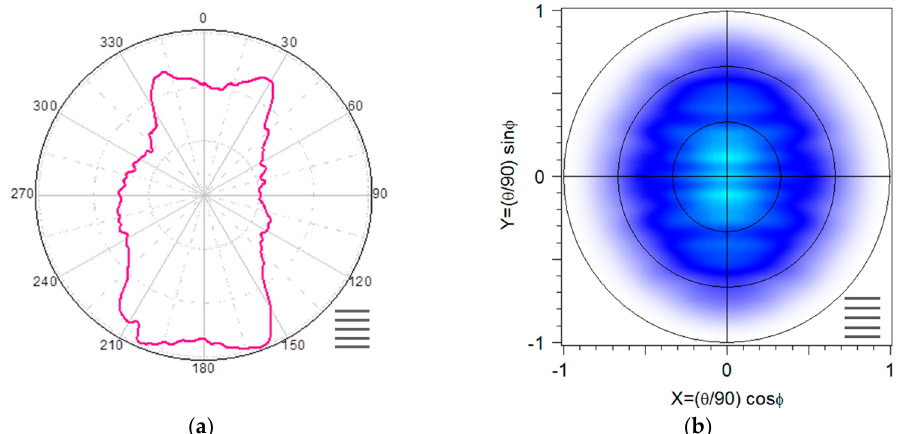
Figure 7. ( a ) Normalized radiation pattern shown as a contour graph for the selected constant intensity and ( b ) the polar projection of the simulated far field of 1D PhC LED.